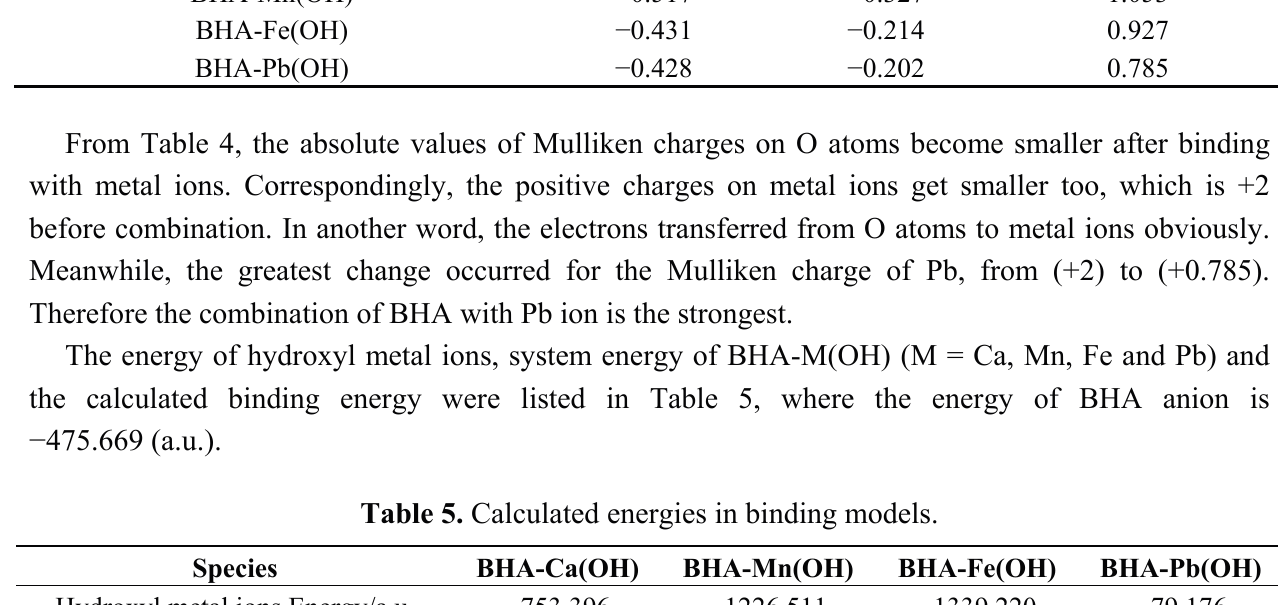
Table 5. Calculated energies in binding models. Species Hydroxyl metal ions Energy/a.u. System